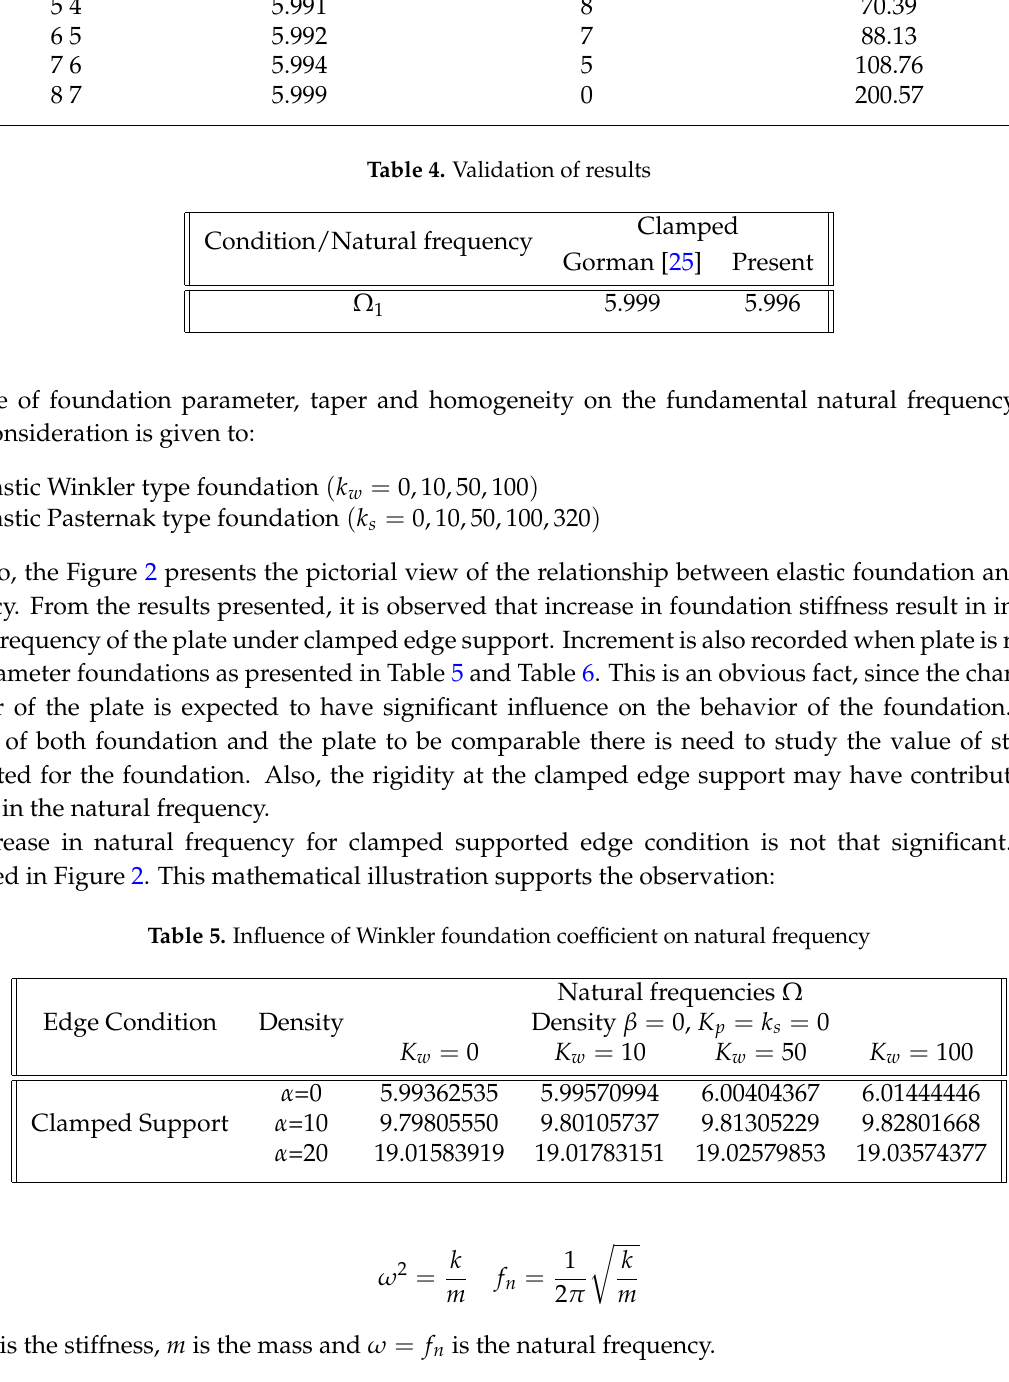
Table 6. Influence of homogeneity on combine Winkler and Pasternak